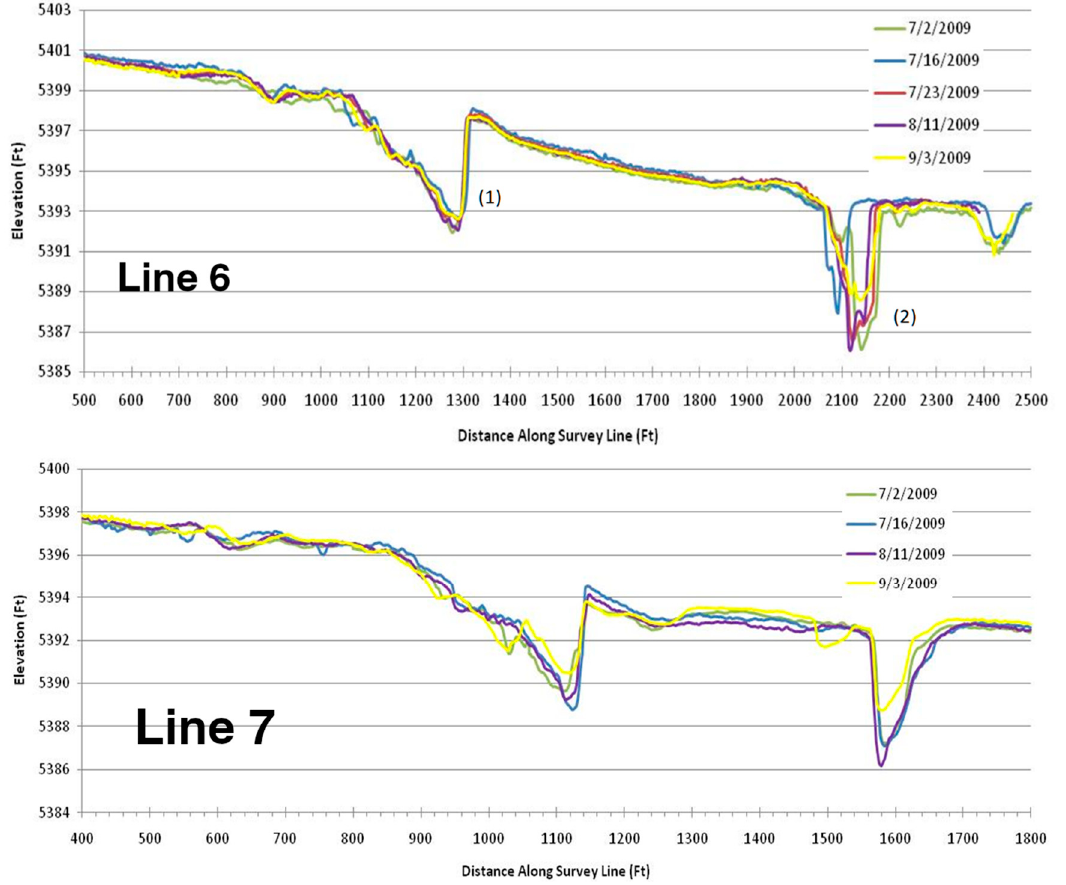
Figure 10. Results for Survey Lines 6 and 7. On both lines, the channel to the right of the figure exhibited the most change.